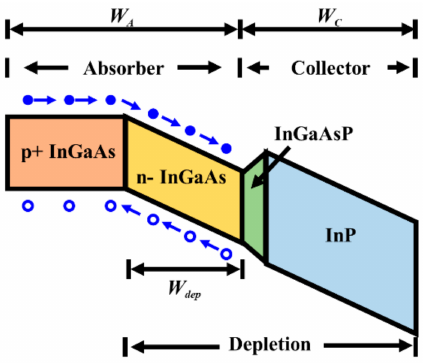
Figure 1. The schematic energy band diagram of MUTC-PD shows the absorber, collector, and InGaAsP transition layers. Arrow indicates the direction of photogenerated electron (solid circle) and hole (open circle)